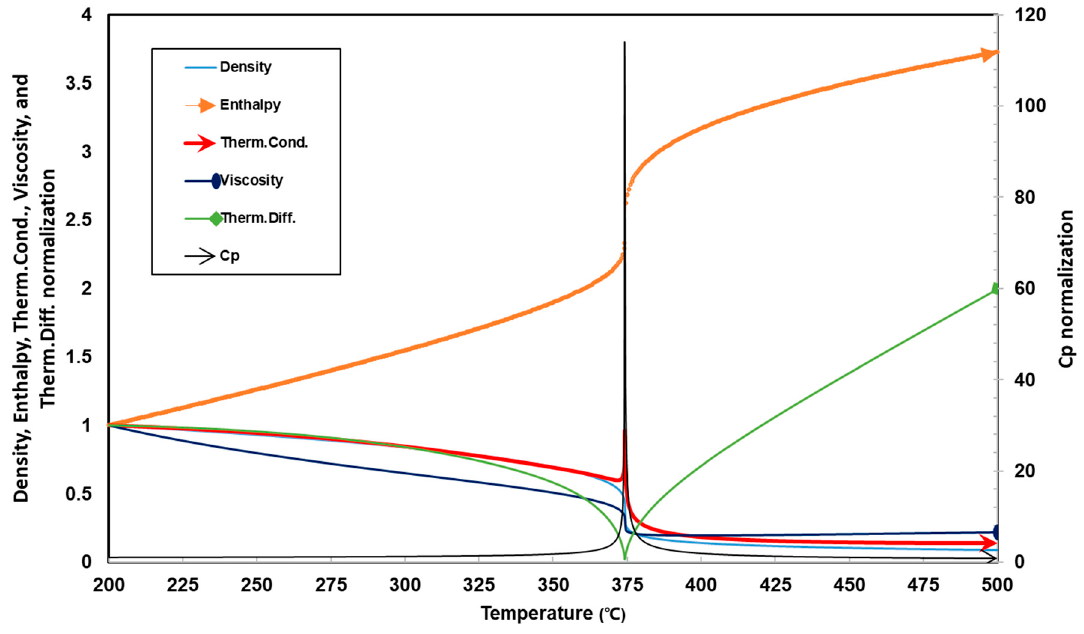
Figure 8. Density, enthalpy, thermal conductivity, viscosity, thermal diffusion and capacity at constant pressure (Cp) normalization as a function of temperature at 22.13 MPa.